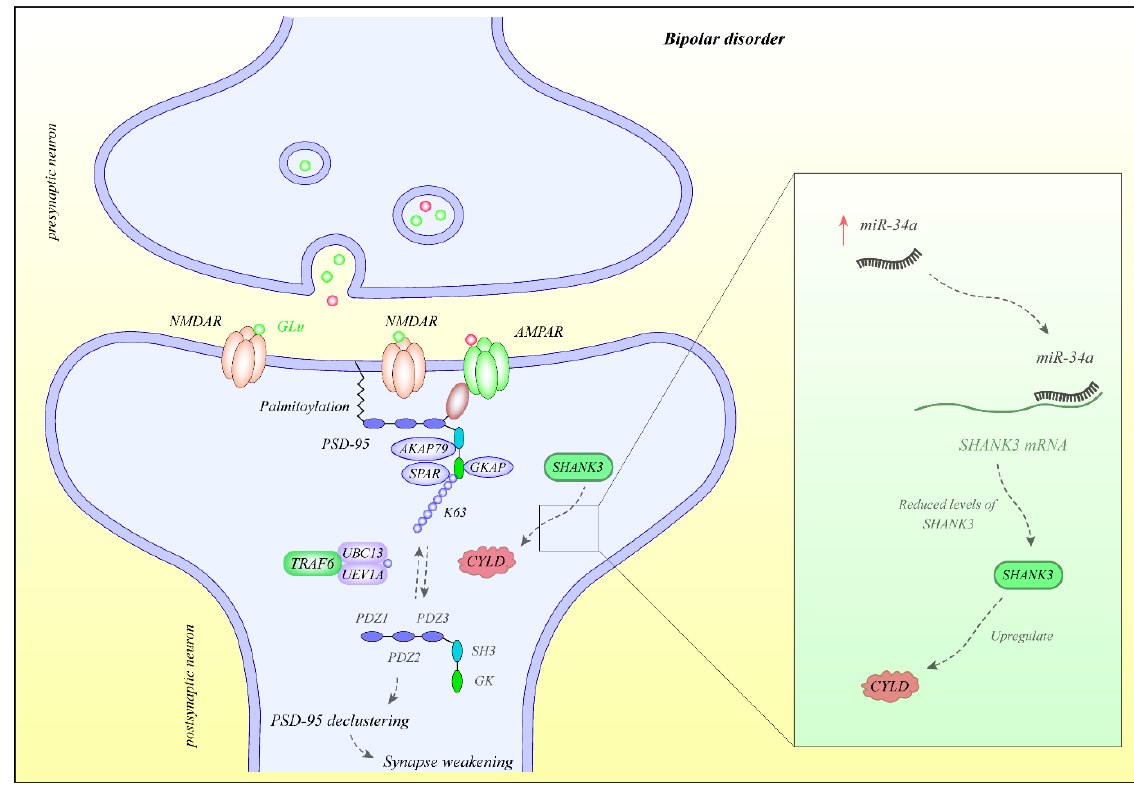
Figure 1. Expression of miR-34a is increased in BD. This miRNA binds with 3' UTR of SHAK3 to decrease its expression. Expression of this protein is correlated with CYLD levels [26,27] . CYLD is a deubiquitinase that targets PSD-95. The latter protein participates in the maturation and function of synapses [28] .